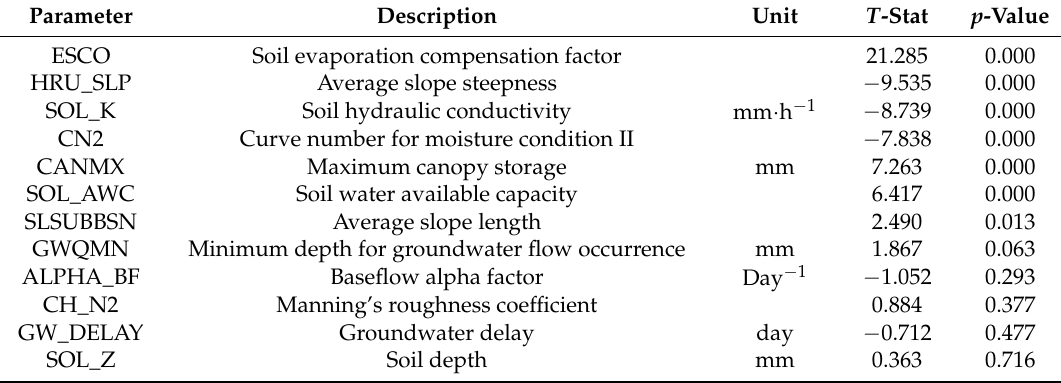
Table 1. SWAT parameter sensitivity to monthly discharge in CRB.